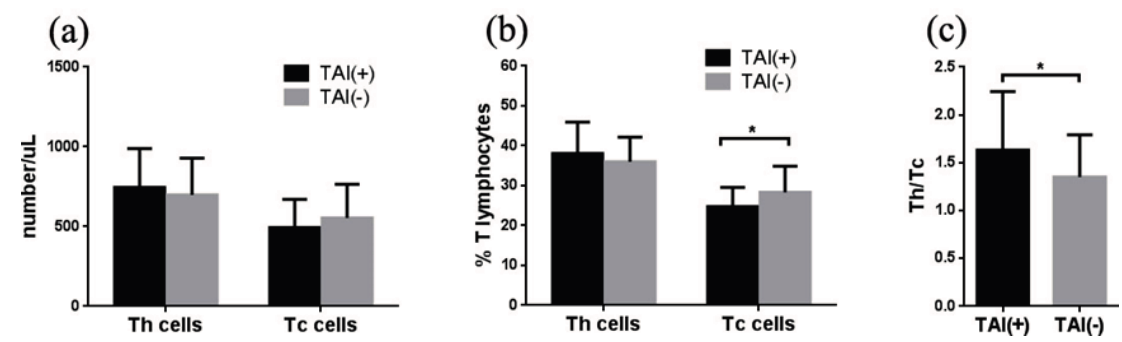
Figure 2. Association of TAI with T subpopulations in women with RIF. ( a ) The number of Th and Tc cells was not significantly different between RIF women with and without